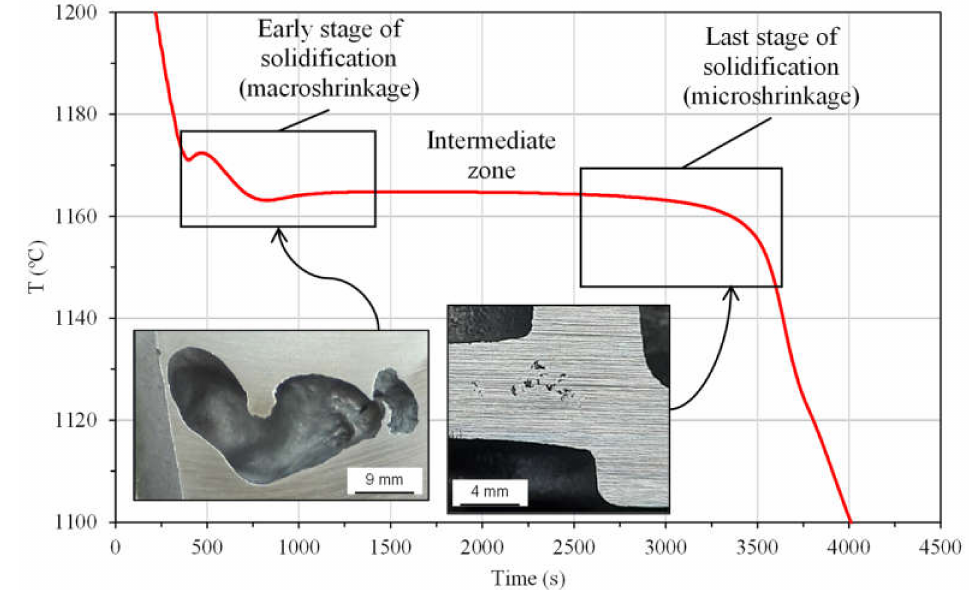
Figure 68. Example of a cooling curve obtained on the center of a ductile iron cylindrical test casting with a thermal modulus of about 4 cm. Solidification areas for primary and secondary shrinkage defects are